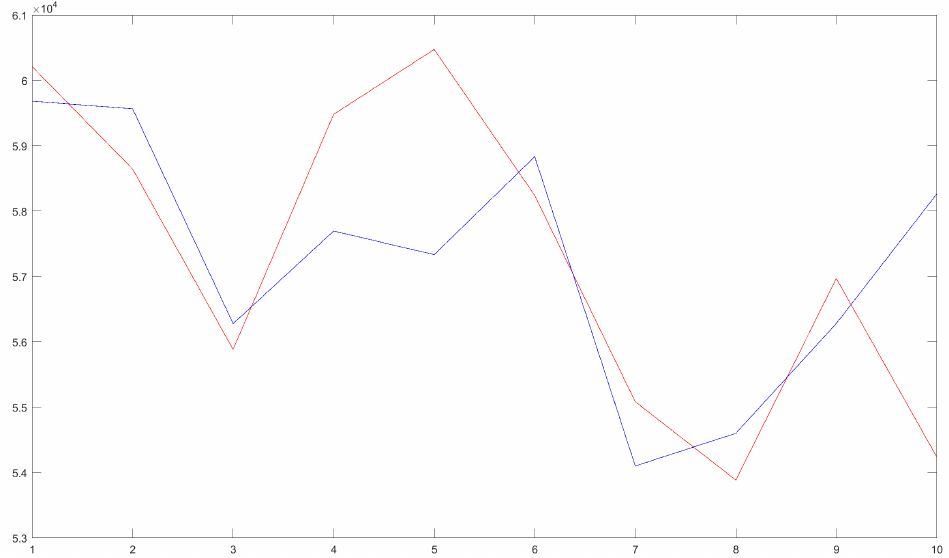
Figure 10. Example of daily price predictions (over ten days) for the opening values of the daily BTS–USD using the TuringBot to evolve formulas that sequentially predict a future price, one-day at a time, using the previous 40-day prices. The actual price data are given by the blue line and the sequential single day predictions are given by the red line for BTC–USD exchange price values from 21 November 2021 to 30 November